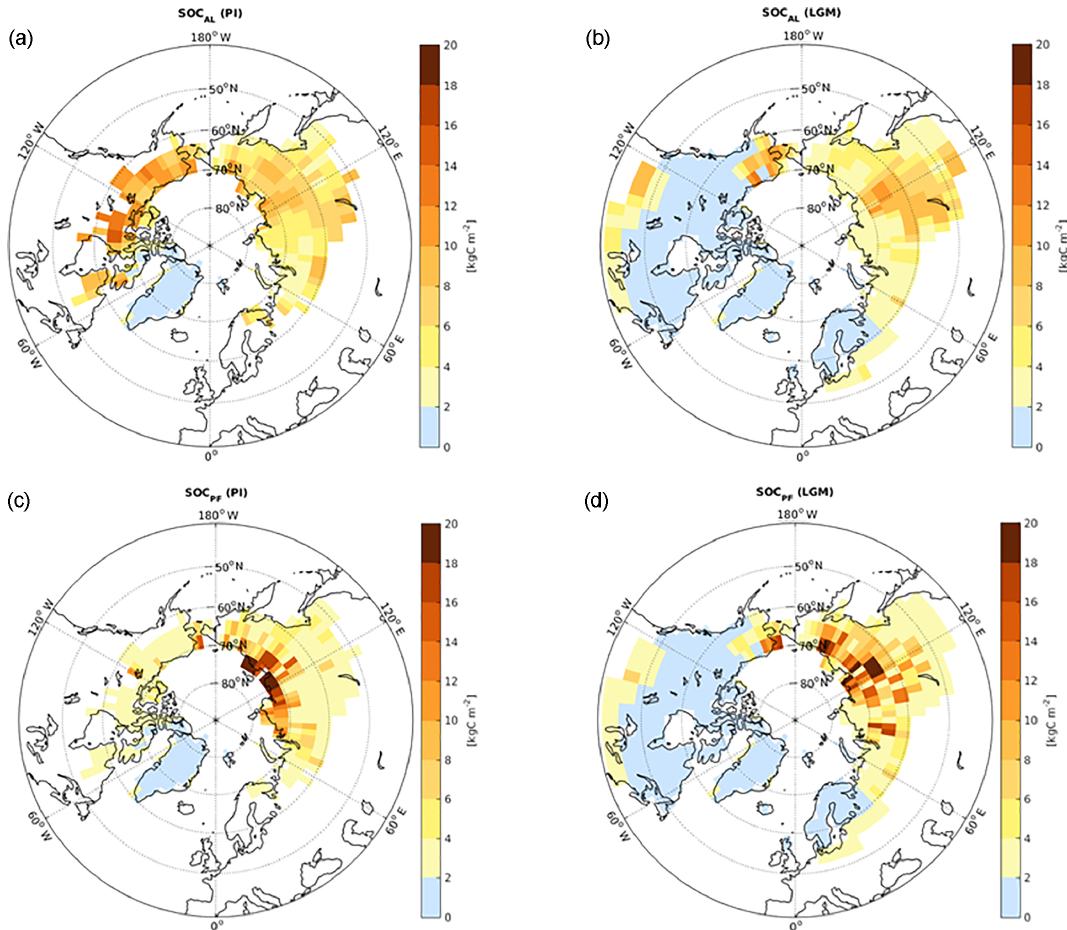
Figure 5. Seasonally thawed SOC in the active layer ( a, b : SOC AL ) and perennially frozen SOC in near-surface permafrost ( c, d : SOC PF ) at PI and LGM simulated by JSBACH. Light bluish areas show prescribed ice sheet coverage. Data shown represent 100-year time